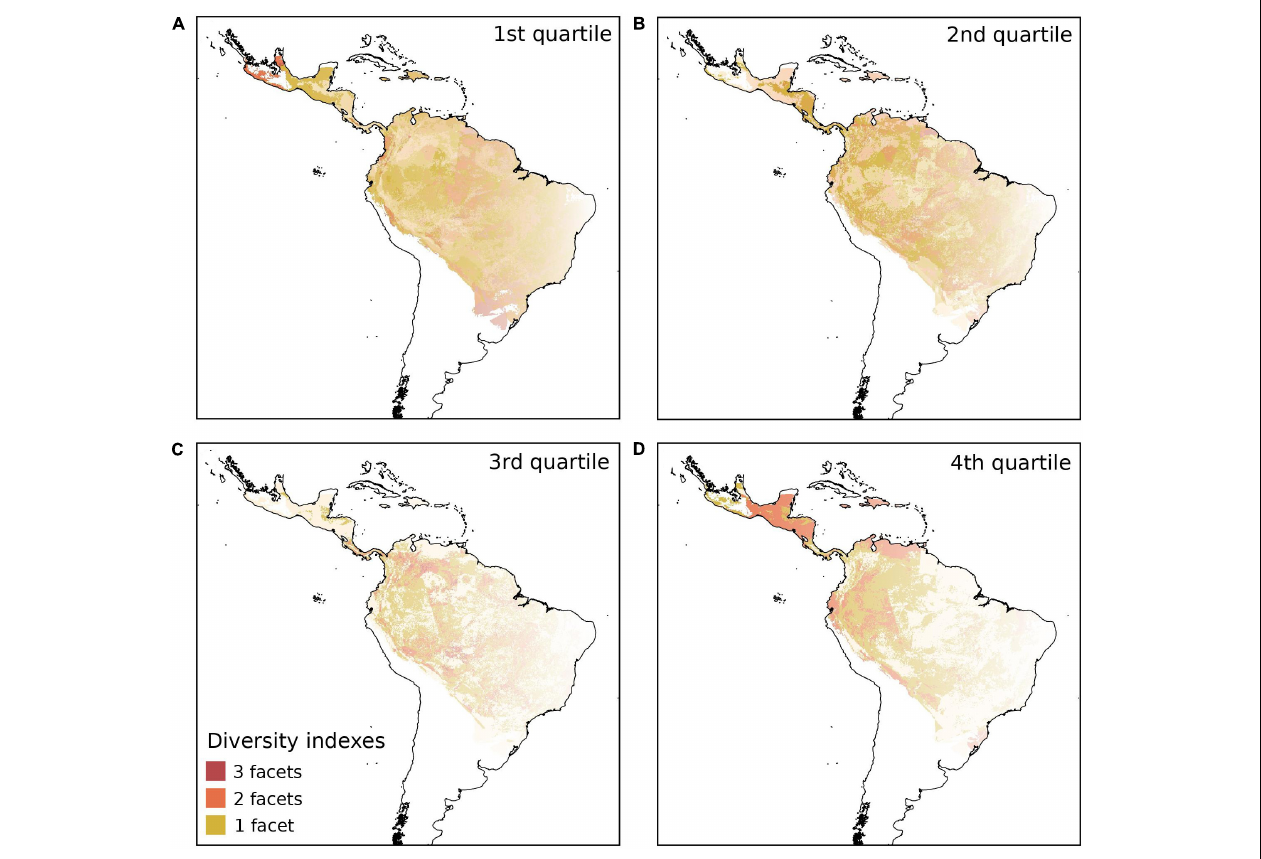
FIGURE 3 | Spatial congruence in taxonomic, phylogenetic and functional diversity measured by Mean Pairwise Distance (MPD) of cocosoid palm species in the Neotropics, for the four quartiles; 1st quartile (A) , 2nd quartile (B) , 3rd quartile (C) and 4th quartile (D) . Dark red shows 100% of spatial congruence among the three diversity indices, orange shows congruence between two indices, and yellow shows no congruence, i.e., the presence of only one of the indices analyzed.